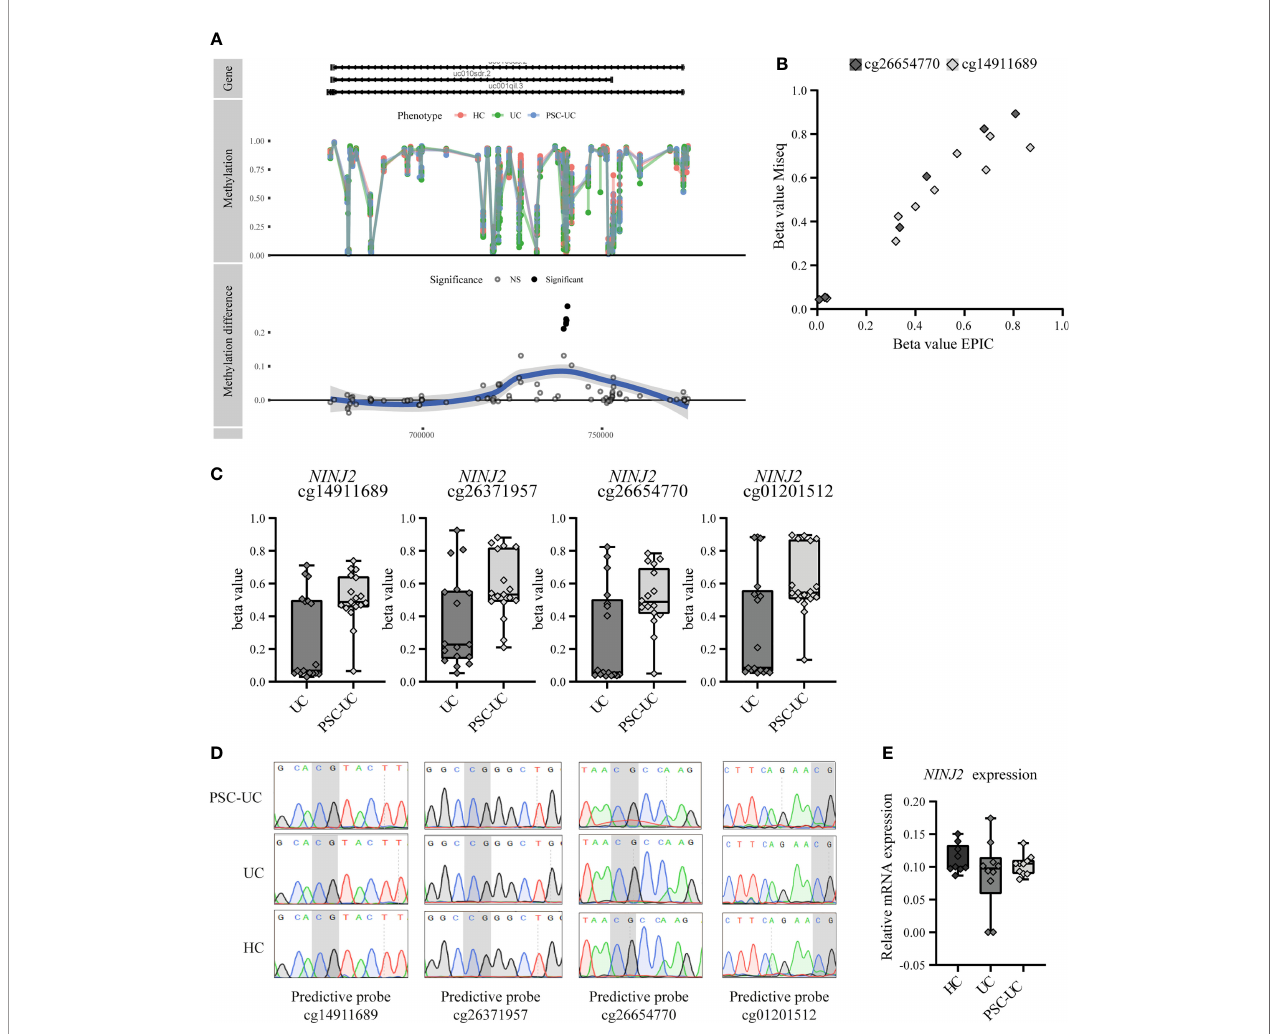
FIGURE 3 | Predictive CpGs annotated to NINJ2 were all hypermethylated in PSC-UC compared to UC patients. (A) Visualization of NINJ2 by plotting the actual percentage methylation for PSC-UC, UC and HC ( “ Methylation ” ) as well as the difference between PSC-UC and UC in percentage methylation ( “ Methylation difference ” ) relative to the position on the genome. (B) Visual correlation of the percentage methylation observed for cg26654770 and cg14911689 as calculated using the 850k DNA methylation array and through MiSeq sequencing for 5 PSC-UC, 2 UC and 2 HC patients. (C) Differences in percentage methylation (beta value) in patients with UC (n = 17) and PSC-UC (n = 17). (D) Representative images of Sanger sequencing traces surrounding the CpG loci of interest (marked in grey) that are annotated to NINJ2 in PSC-UC (n = 14), UC (n = 13) and HCs (n = 12). (E) Relative mRNA expression of NINJ2 normalized to the household genes GAPDH and HPRT in peripheral blood mononuclear cells of PSC-UC (n = 10), UC (n = 10) and HCs (n =